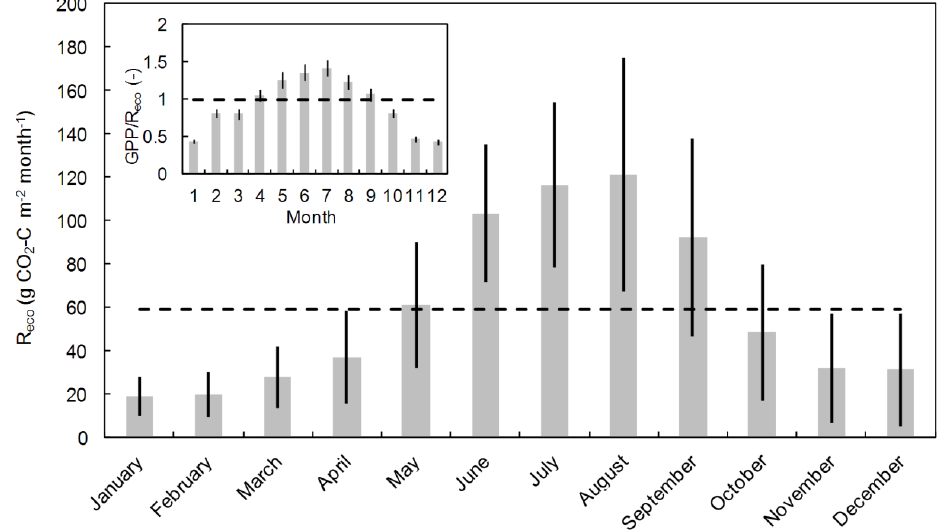
Figure 2. 10-year monthly averages of ecosystem respiration and, inset, ratio of gross primary production (GPP) to ecosystem respiration (horizontal dashed lines are 10-year annual mean, and error bars are the standard